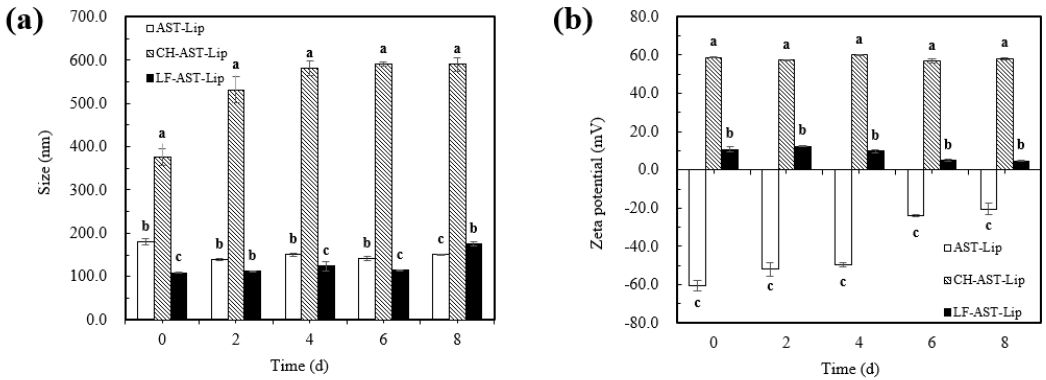
Figure 7. Particle size ( a ) and zeta potential ( b ) of samples during storage at 25 °C. Different lowercase letters indicate significant differences between groups ( p < 0.05).